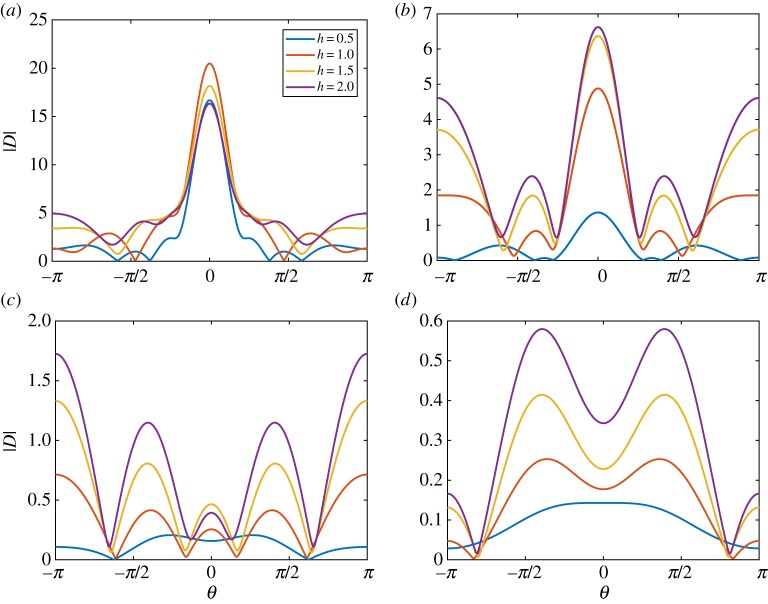
The absolute value of the far-field scattering |D(θ)| for a wave of period (a) T = 6 s, (b) T = 8 s, (c) T = 10 s and (d) T = 12 s. The floe is of radius a = 50 m, and thicknesses h = 0.5, 1.0, 1.5 and 2.0 m. (Online version in colour.)